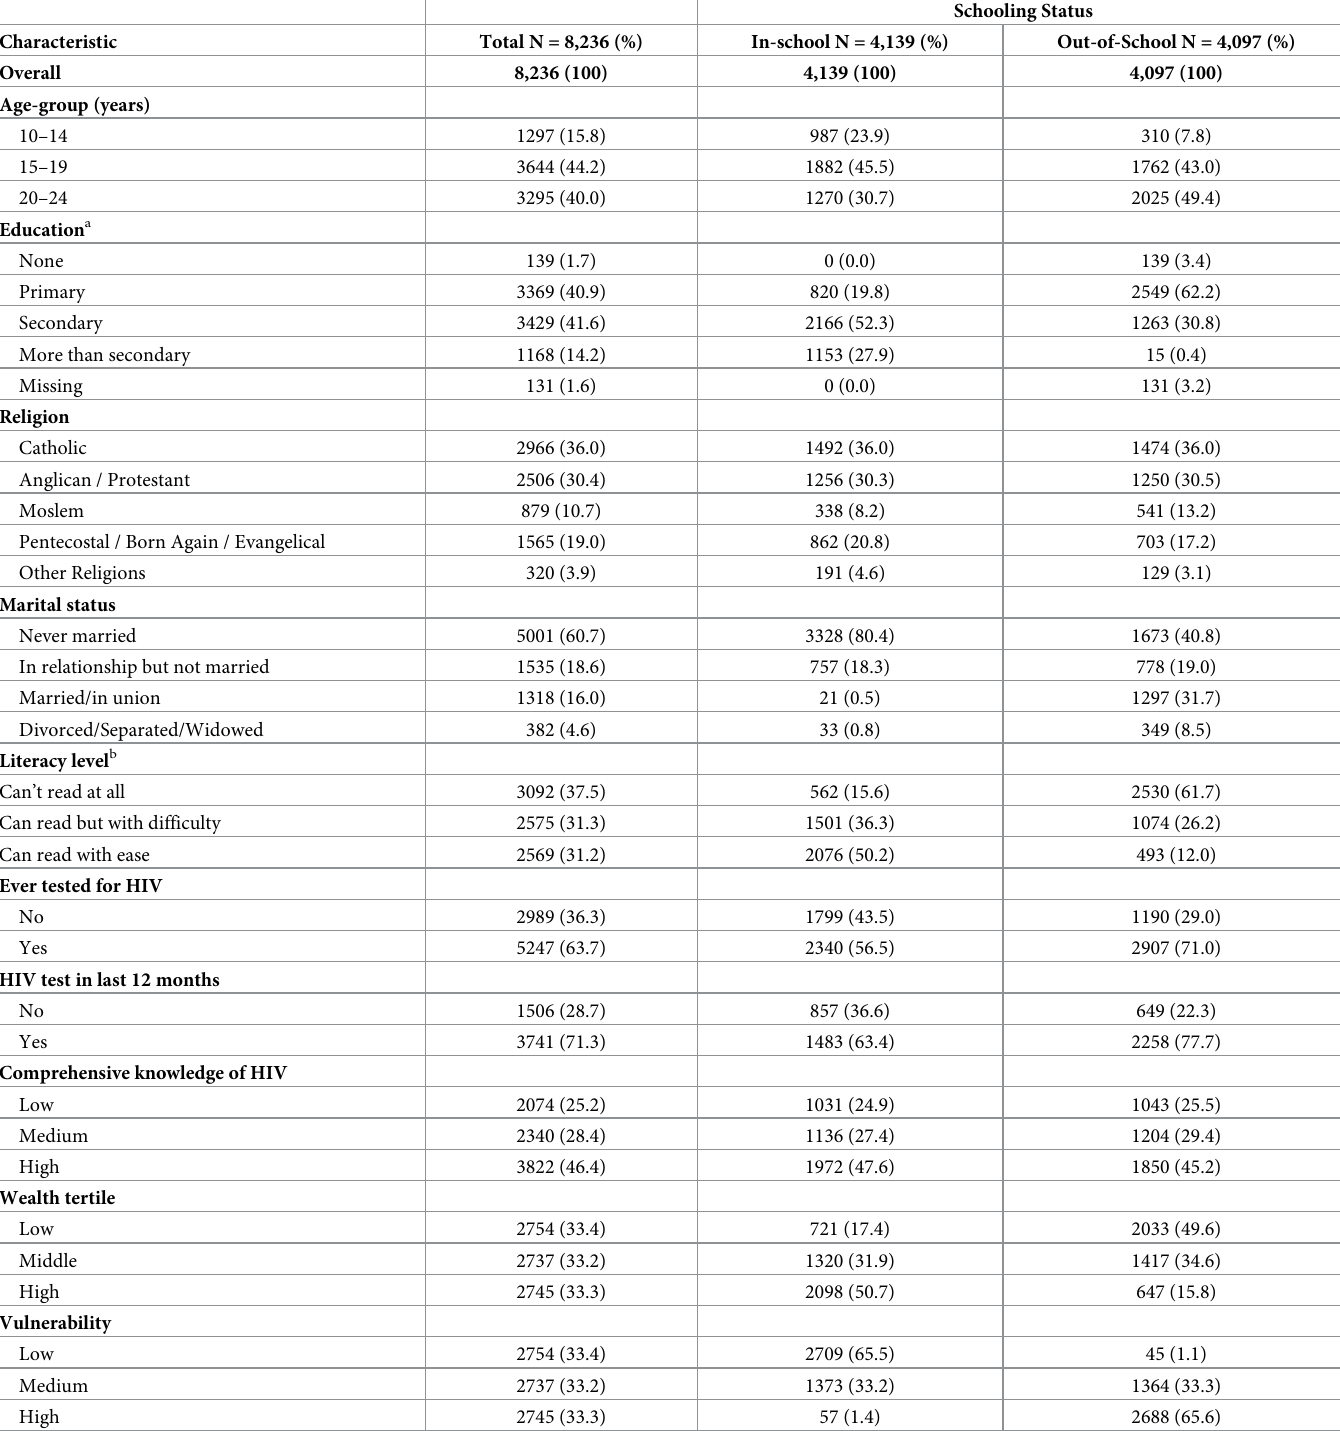
Table 1. Background characteristics of AGYW by schooling